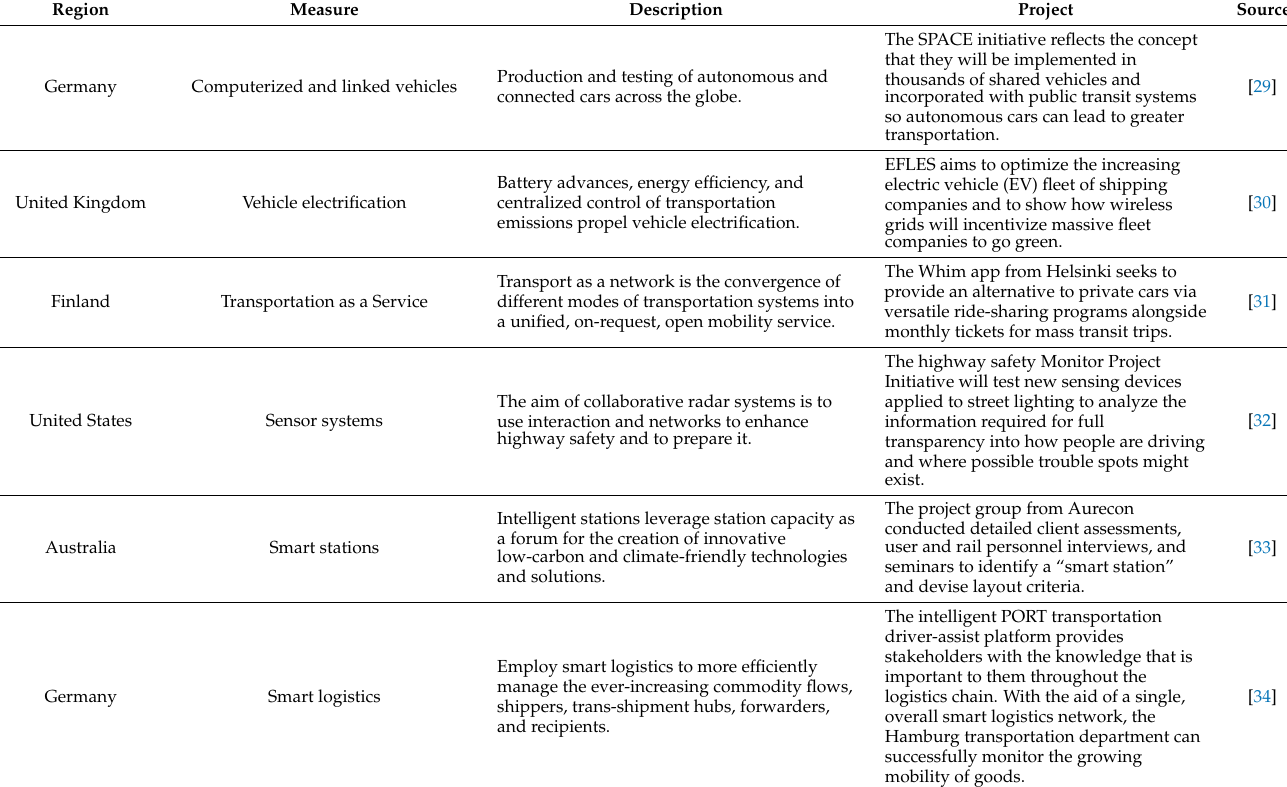
Table 5. Finest smart mobility